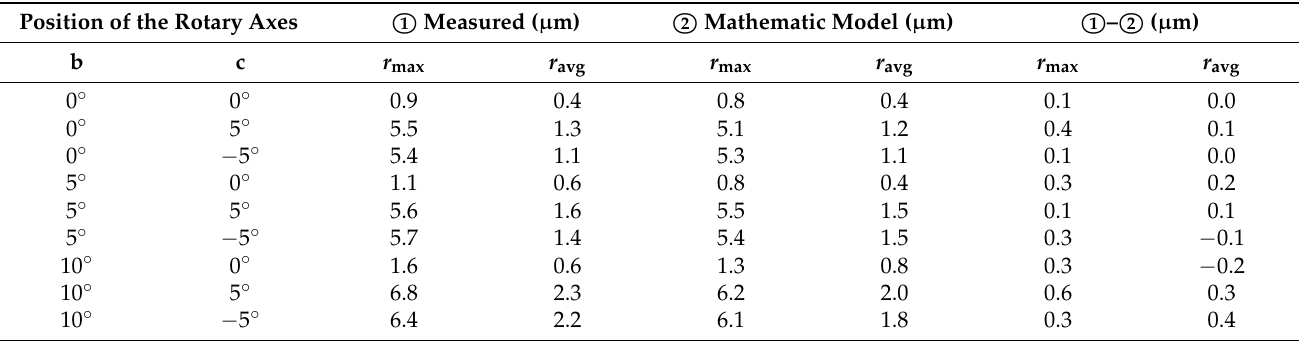
Figure 6. Geometrical definition of a five-standard sphere artefact. Table 2. Error of fiducial distances compared with the datasets in FACAD when using the measured results and mathematic model under different rotation angles of